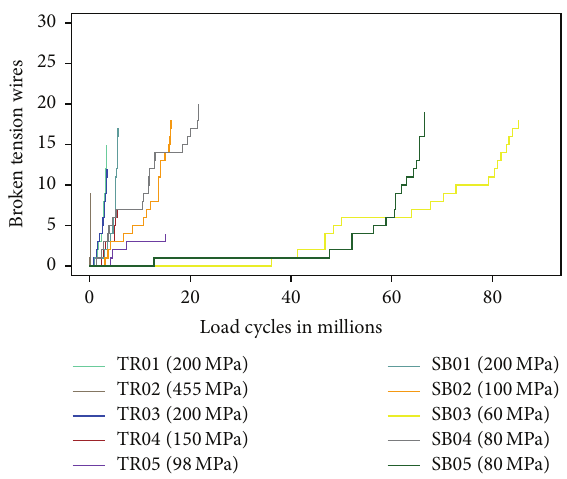
Figure 3: Tests results for TR01–TR05 and